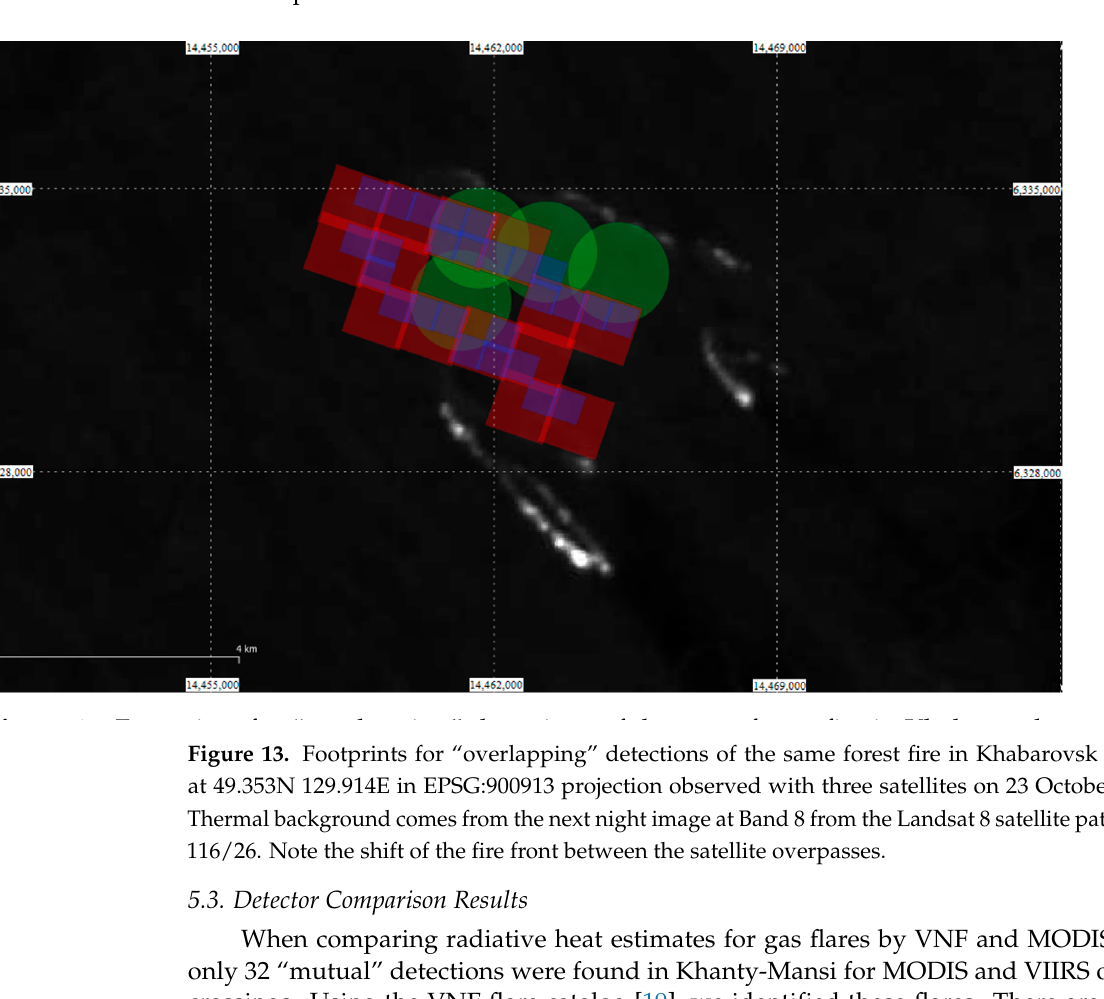
( b ) Figure 14. Comparison of VNF and AFP radiative heat estimates for gas flares: ( a ) VNF vs. MODIS AFP; ( b ) VNF vs . VIIRS AFP. A comparison of the MWIR detection probability of gas flares by VNF vs MODIS and VIIRS AFP is shown in Figure 15. The detection probability by VNF for gas flares is higher than by both MODIS and VIIRS AFP.